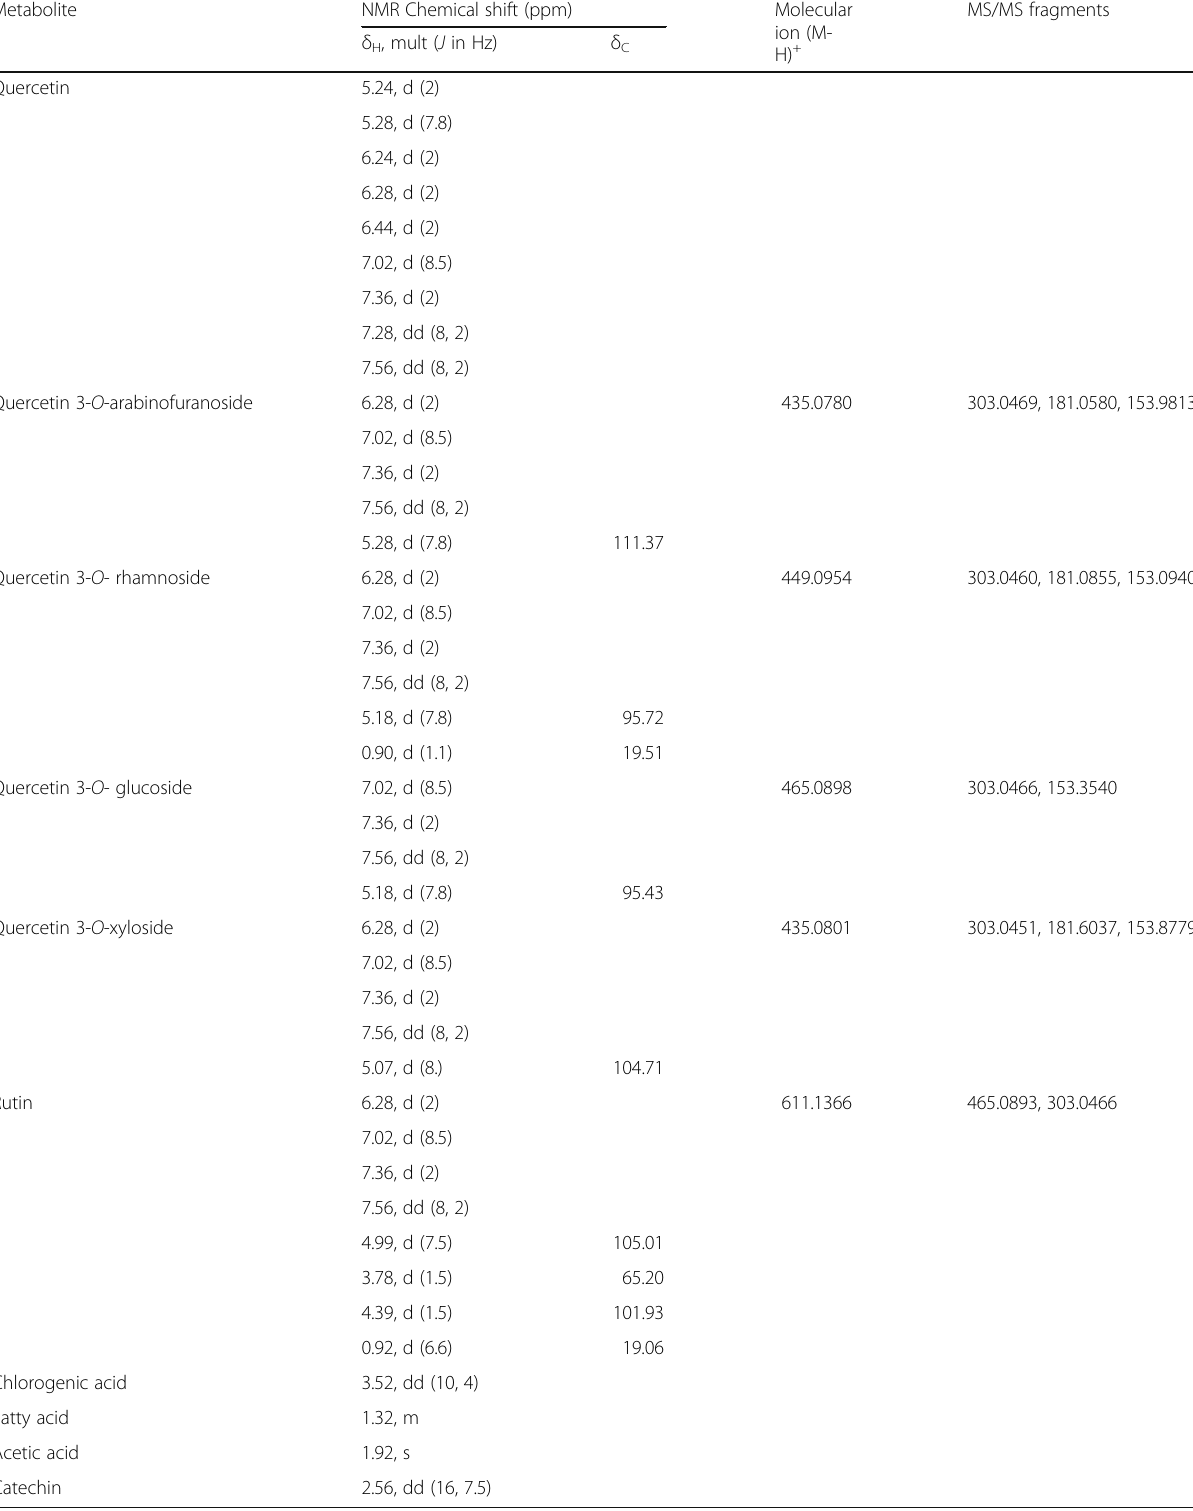
Table 2 1 H NMR, 13 C NMR characteristic signals and LC-MS/MS data of identified metabolites in C. caudatus